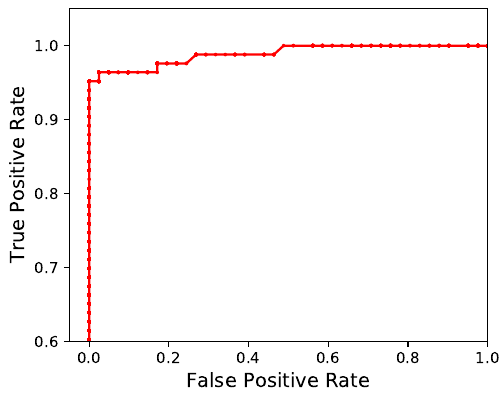
Figure 5. A receiver-operating characteristic curve showing the true-positive and false-positive rate produced by a range of thresholds when used by the bat detection